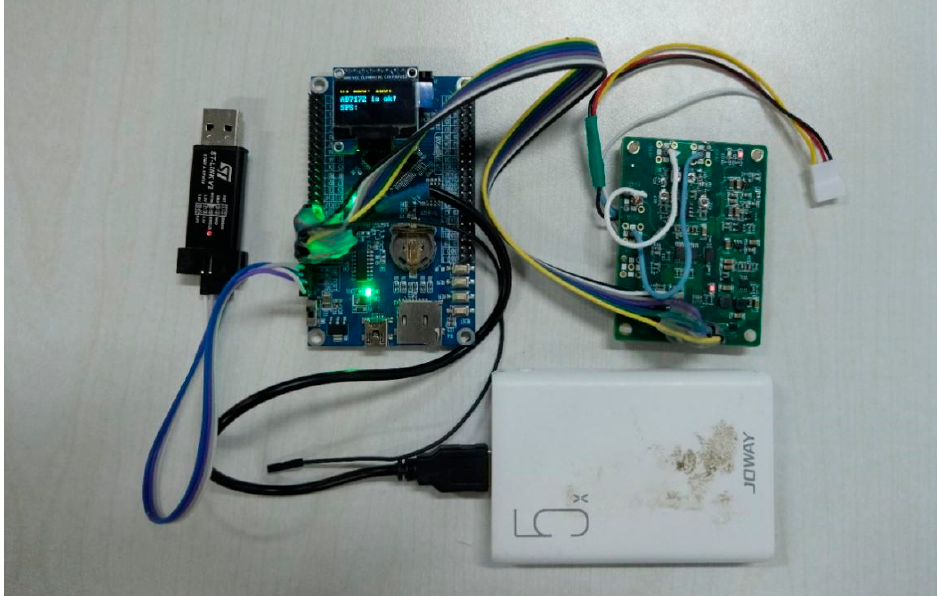
Figure 4. The connection between the electrical parts of our device. The main control board was composed of an stm32f767ZI chip, an ssd1306 display module, a Bluetooth communication module, and its peripheral circuits. Its function in- cludes controlling the collection board, distributing clock frequency, performing Bluetooth communication, circuit self-testing, surface contact resistance measuring, and displaying relevant information in the display module, as shown in Figure 5.